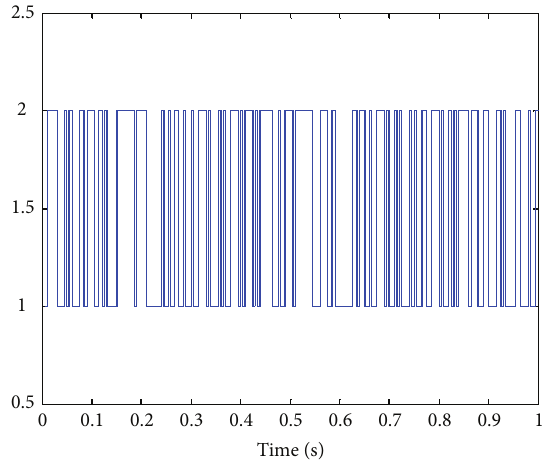
Figure 6: The random switched rule 𝜎(𝑡) for system (2).